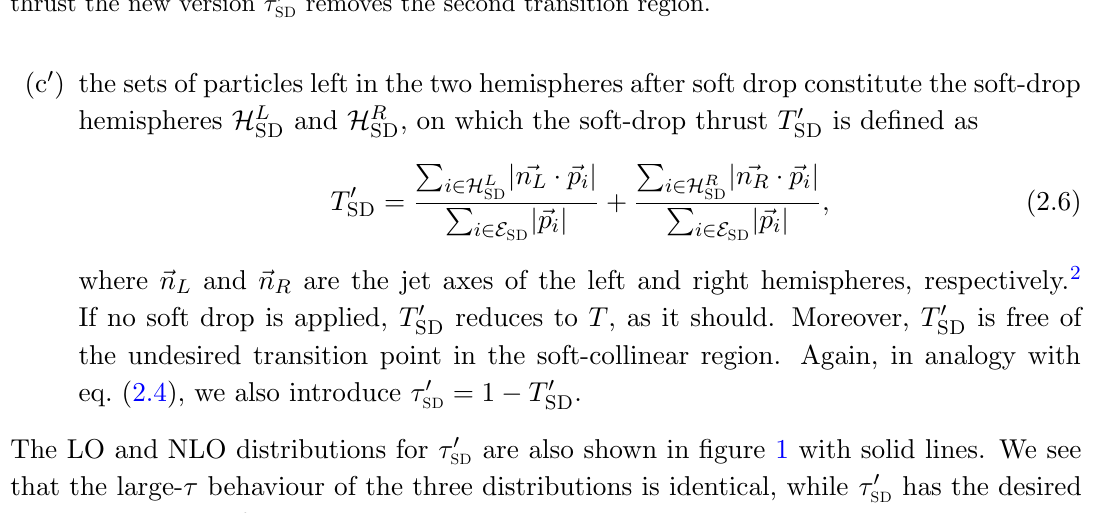
Figure 1 . Fixed order thrust calculated from EVENT2 , LO on the left and NLO on the right. The dotted red lines show the original de(cid:12)nition of thrust, while the solid red lines show its new incarnation. The two de(cid:12)nitions coincide for the ungroomed case (solid blue), while for soft-drop thrust the new version (cid:28) 0 SD removes the second transition